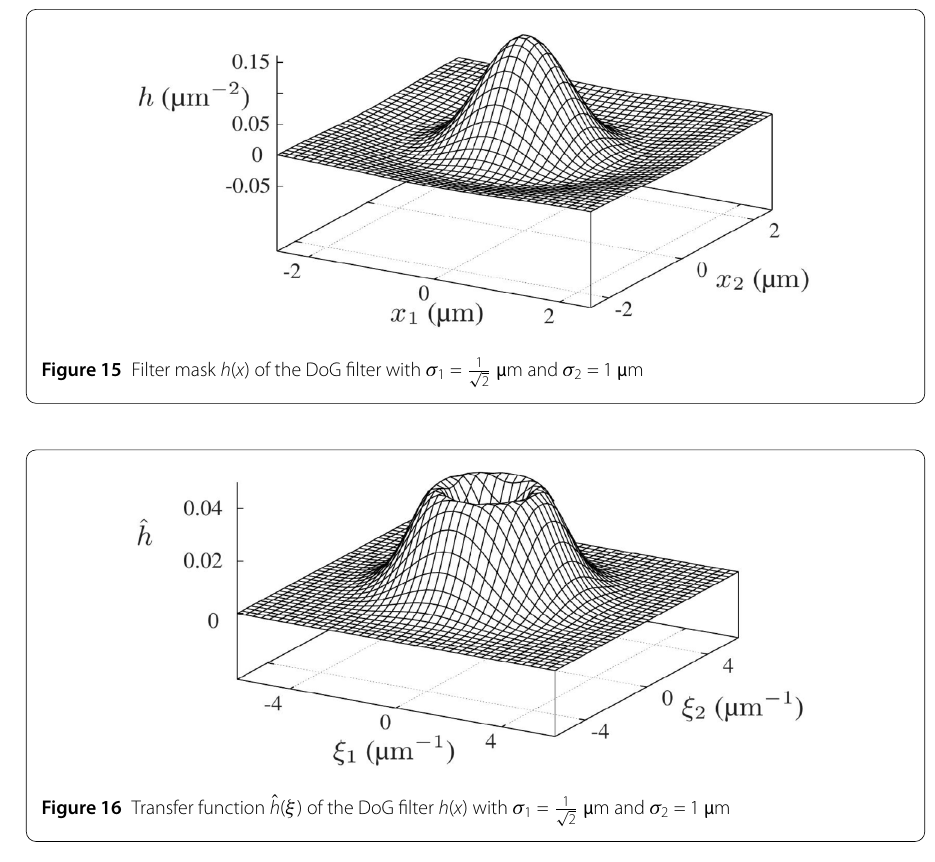
Figure 16 Transfer function ˆ h ( ξ ) of the DoG filter h ( x ) with σ 1 = 1 √